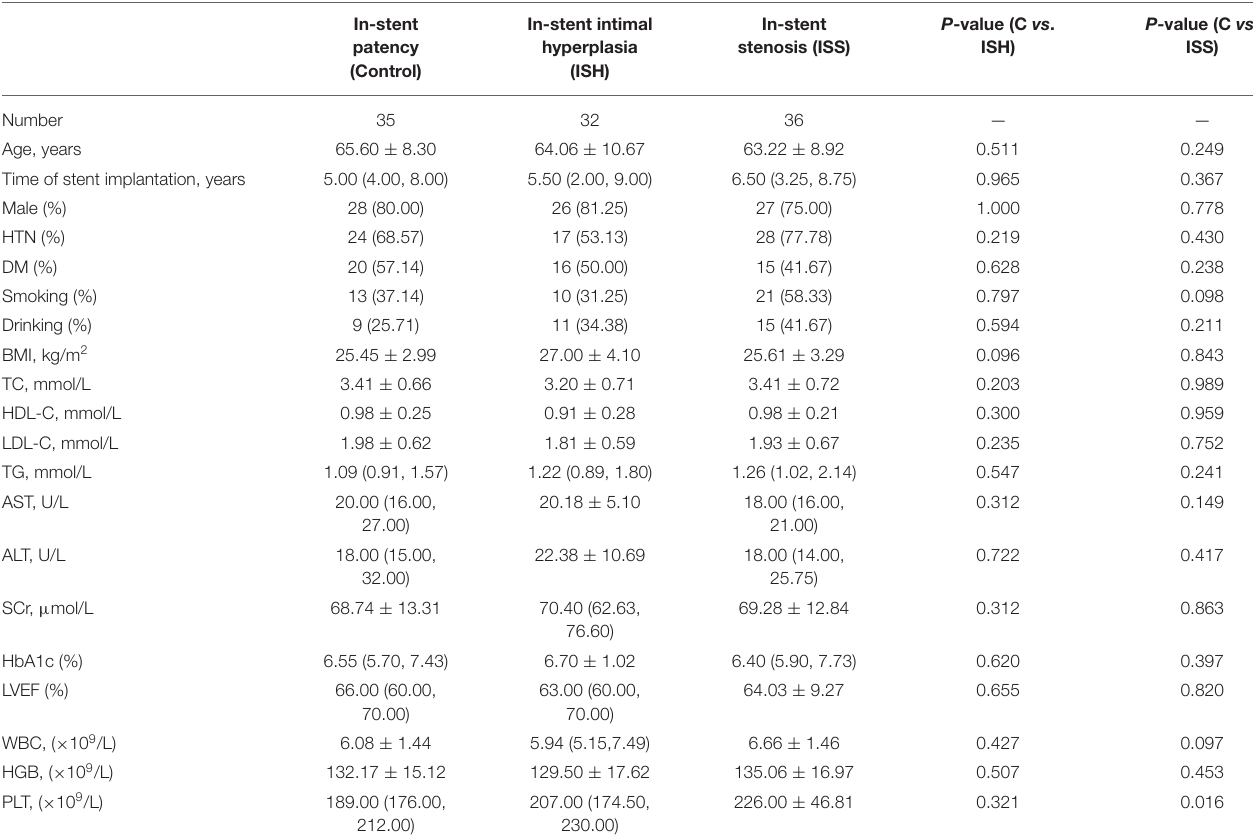
TABLE 1 | Baseline clinical characteristics of participants in study.